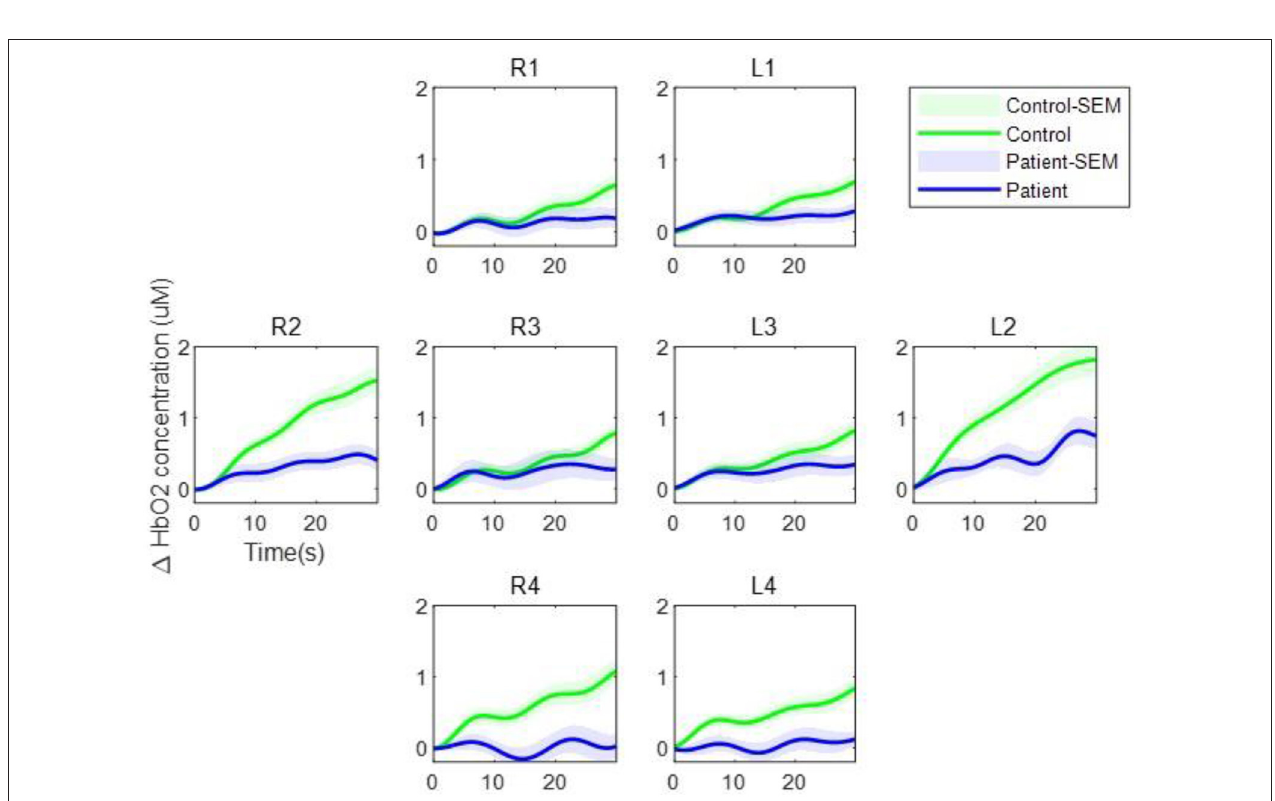
FIGURE 3 | Transient oxygenated hemoglobin concentration during the verbal fluency task. The green line represents the control group while the blue line represents the patient group. The shaded regions represent the standard errors of the mean.